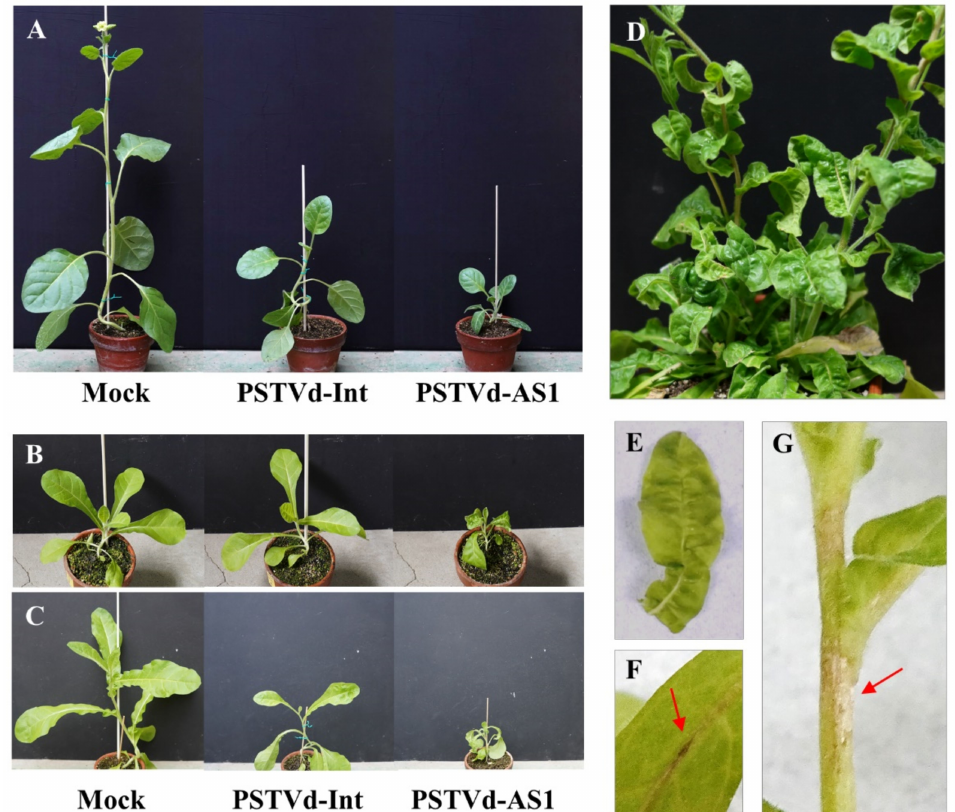
Figure 9. Symptoms in Nicotiana plants infected with PSTVd. ( A ) At 8 weeks post-inoculation (wpi), stunting, leaf miniaturization, and poor growth were observed in PSTVd-infected N. rustica plants and were more severe during PSTVd-AS1 infection. ( B ) At 3 wpi, N. occidentalis plants inoculated with 5 µ g RNA per plant clearly exhibited disease symptoms only after inoculation with PSTVd-AS1. ( C ) At 3 wpi, N. occidentalis plants inoculated with 10 µ g RNA per plant exhibited stunting even by inoculation with PSTVd-Int. ( D – G ) N. occidetalis plants infected with PSTVd-AS1 exhibited disease symptoms such as leaf curling, rugose, and vein/stem necrosis in addition to stunting. ( D ) Rugose and leaf curling at 7 wpi. ( E ) Leaf rugose at 3 wpi. ( F ) Vein necrosis at 3 wpi (indicated with a red arrow). ( G ) Stem necrosis at 4 wpi (indicated with a red